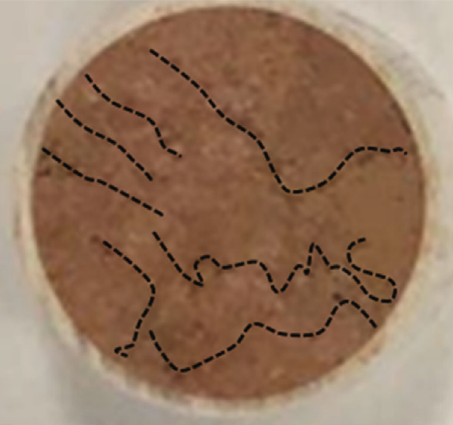
Figure 7: Cracks development photo of specimen after seven drying – wetting